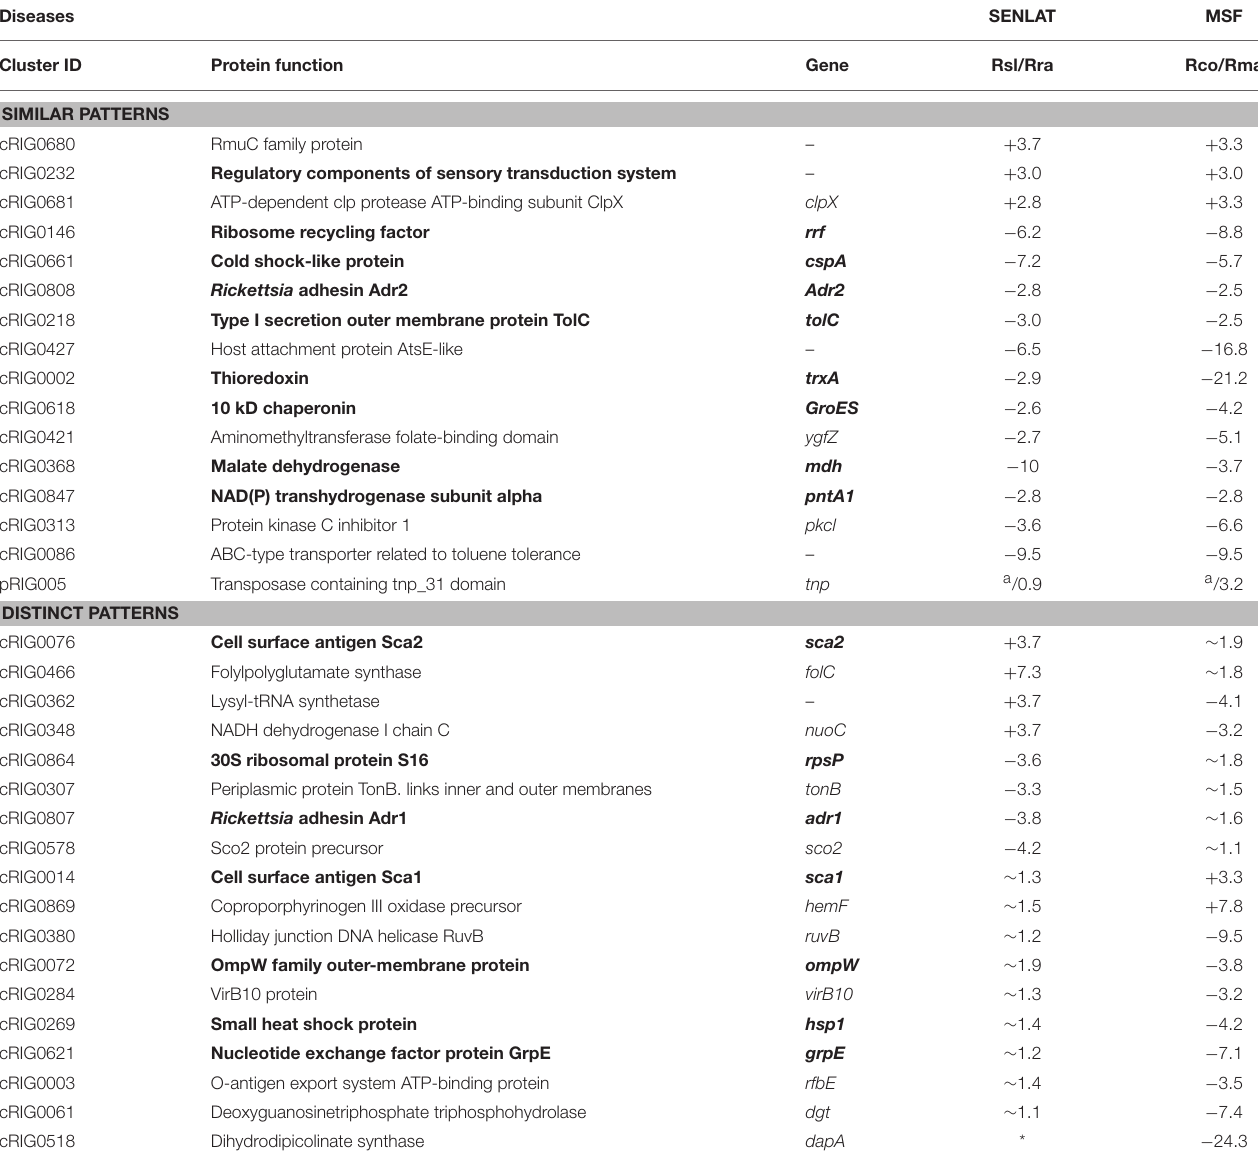
TABLE 1 | Examples of protein patterns obtained between the SENLAT agents (the virulent R. slovaca Rsl/the milder R. raoultii Rra) and between the MSF agents (the virulent R. conorii Rco/the milder R. massiliae Rma). Diseases